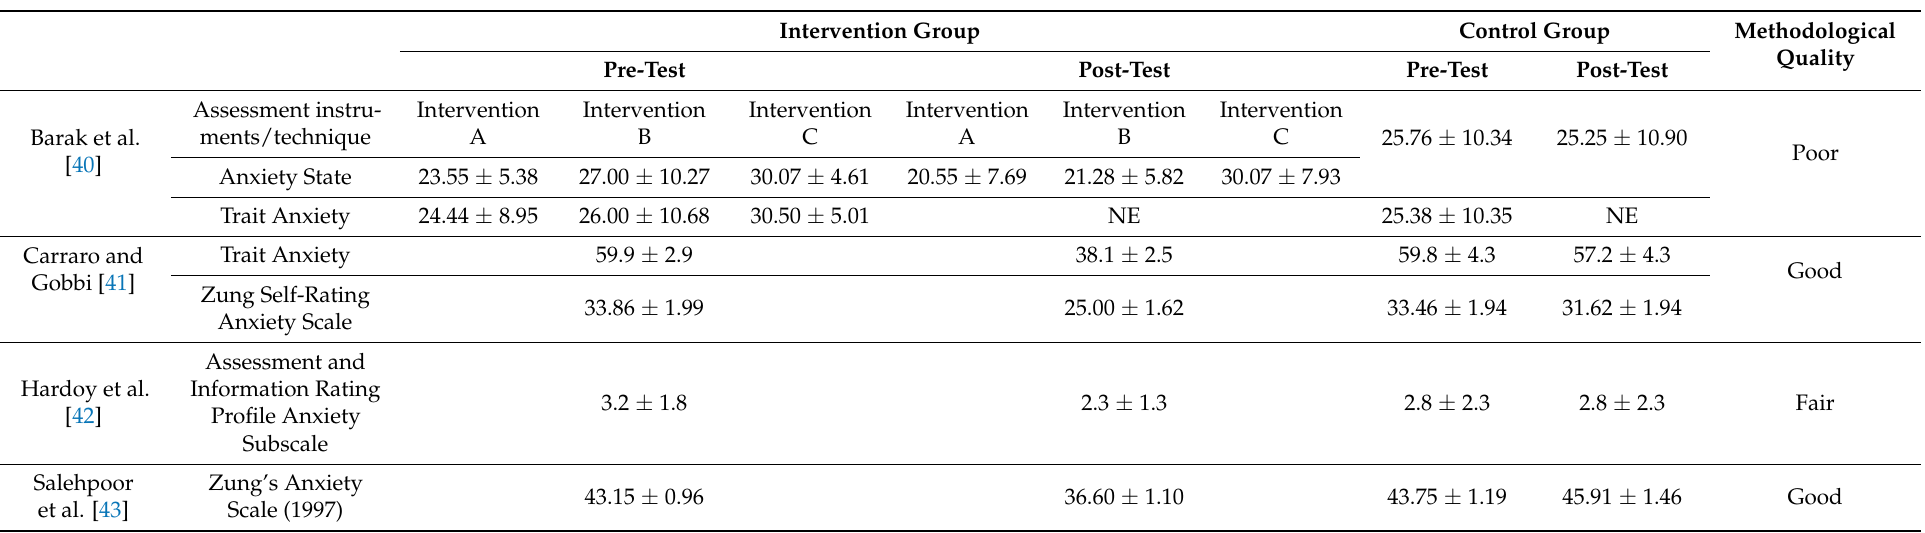
Table 3. Results of the interventions on anxiety